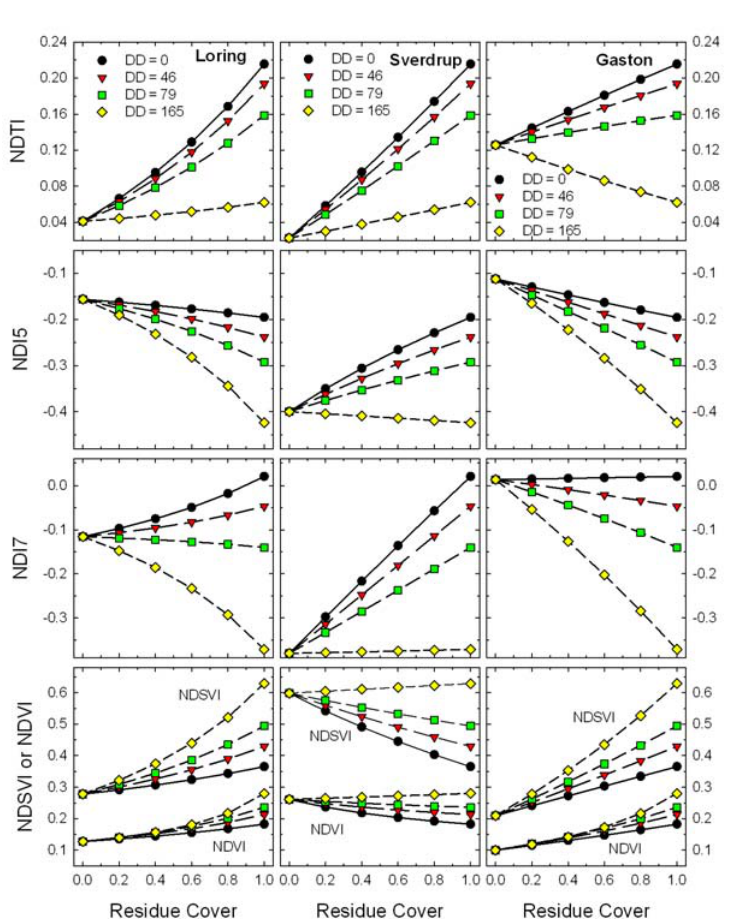
Figure 8 . Expected responses of Landsat TM band residue indices (Equations 2–6) to changes in residue cover for scenes with mixtures of four ages ( i.e., decomposition days, DD) of wheat residues and three